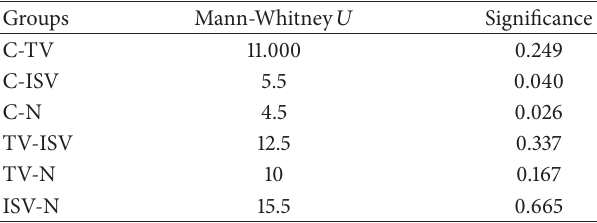
Table 4: Comparisons between the four groups in terms of clinical score on day